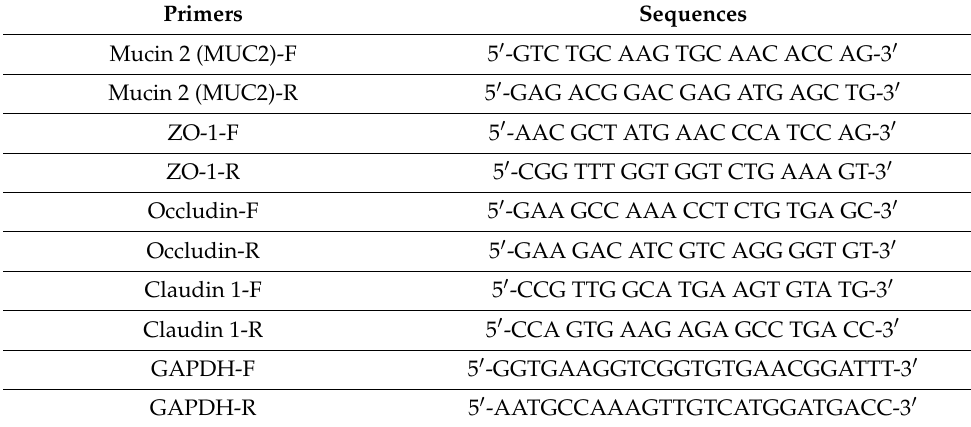
Table 1. List of primers for RT- and semi-quantitative real-time